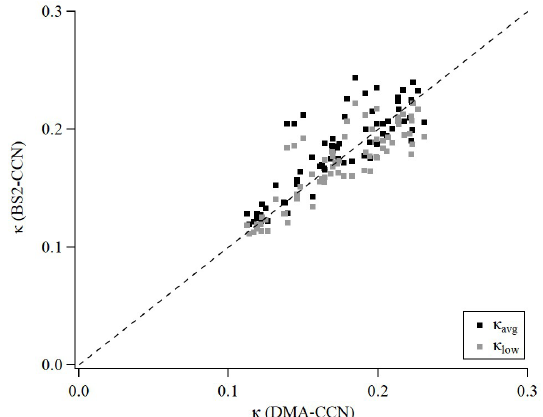
Figure 10. Scatterplot of κ between DMA-CCN and BS-CCN mea- surements. The black square and grey square dots indicate κ avg (calculated from the calibration curve of F act , µ ) and κ low (calcu- lated from the calibration curve of F act_high , µ + σ ) for the BS2- CCN measurement, respectively. For comparison, the κ value from a BS2-CCN measurement at the diameter adjacent to the critical di- ameter obtained from the DMA-CCN measurement was selected. The black dashed line is a 1 : 1 line for